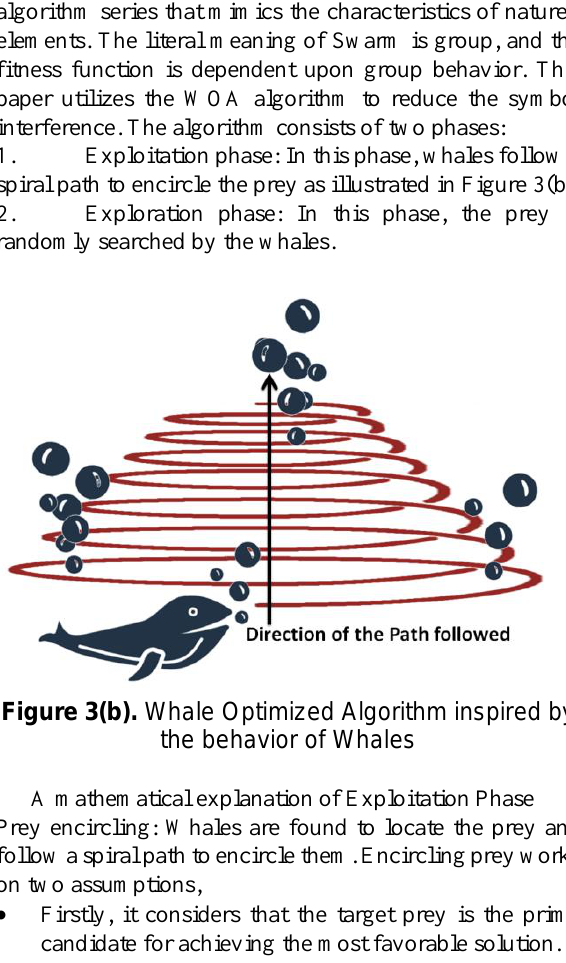
Algorithm 1: Optimization using